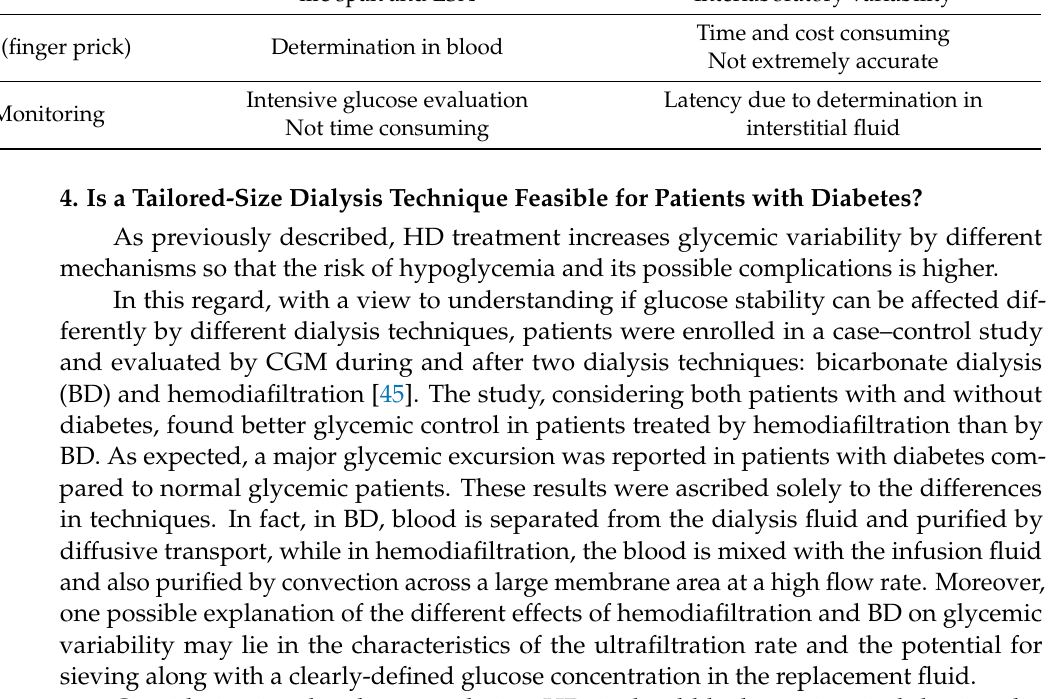
Table 1. Current methods for assessing glycemic control: advantages and disadvantages (ESA: Erythropoiesis-stimulating agents). Advantage Disadvantage Long-term glycemic control Not influenced by reduced red blood life span and ESA life span and ESA Determination in blood Intensive glucose evaluation Not time consuming